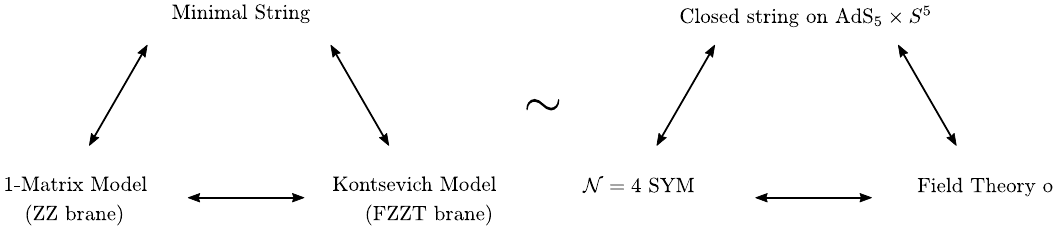
Figure 11 . Open-closed-open duality. The (cid:12)eld theory of (cid:26) can be regarded as an analogue of the Kontsevich model in the minimal string